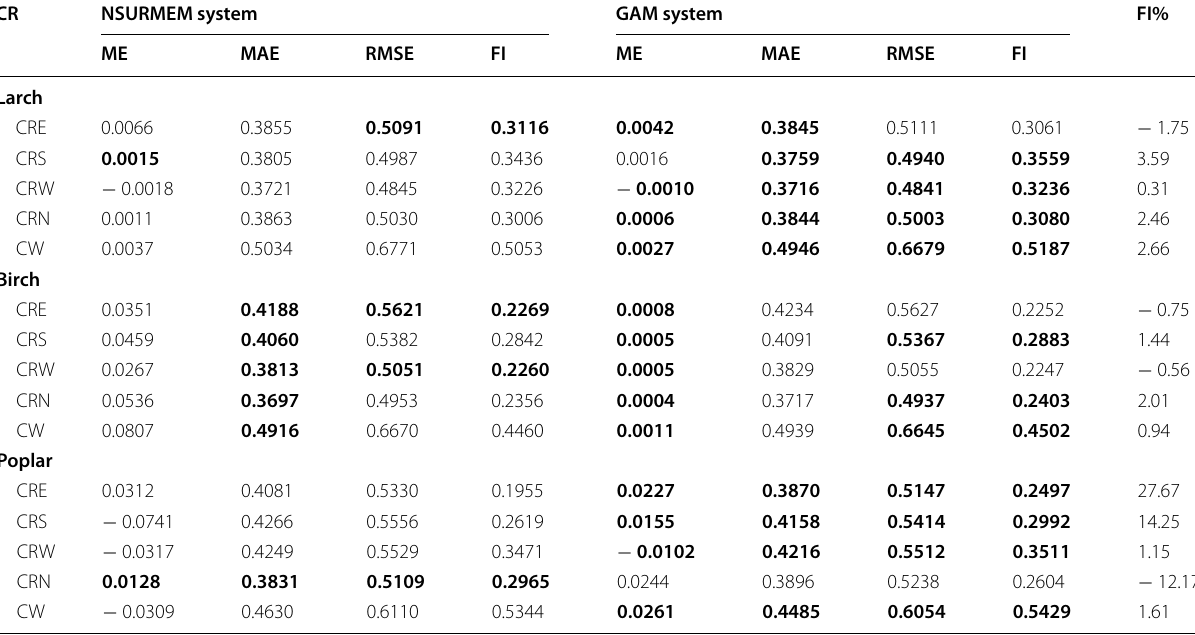
Note : The bolded numbers indicate the best performance for each case of the NSURMEM and GAM